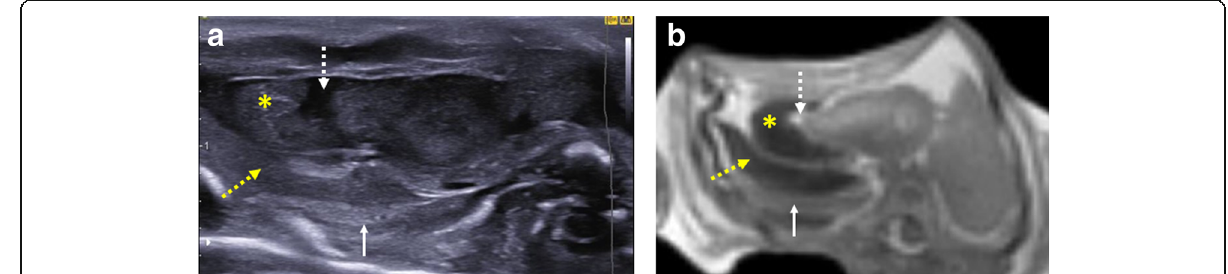
Fig. 9 Transverse imaging through the lower thoracic cavity in a 20-week gestational-aged foetus, 2 days after death following termination of pregnancy for suspected renal agenesis. Termination was performed by in utero foetal intra-cardiac injection of potassium chloride. Postmortem ultrasound ( a ) and postmortem T2-weighted MRI at 1.5 T ( b ) both demonstrate haemorrhage within the right pericardial (yellow asterisk) and pleural space (yellow dotted arrow). It is also possible to visualise the ‘ normal ’ consolidated right lower lobe of the lung (white solid arrow) and a small pericardial effusion (white dotted arrow). These are typical foeticide-related changes and iatrogenic in